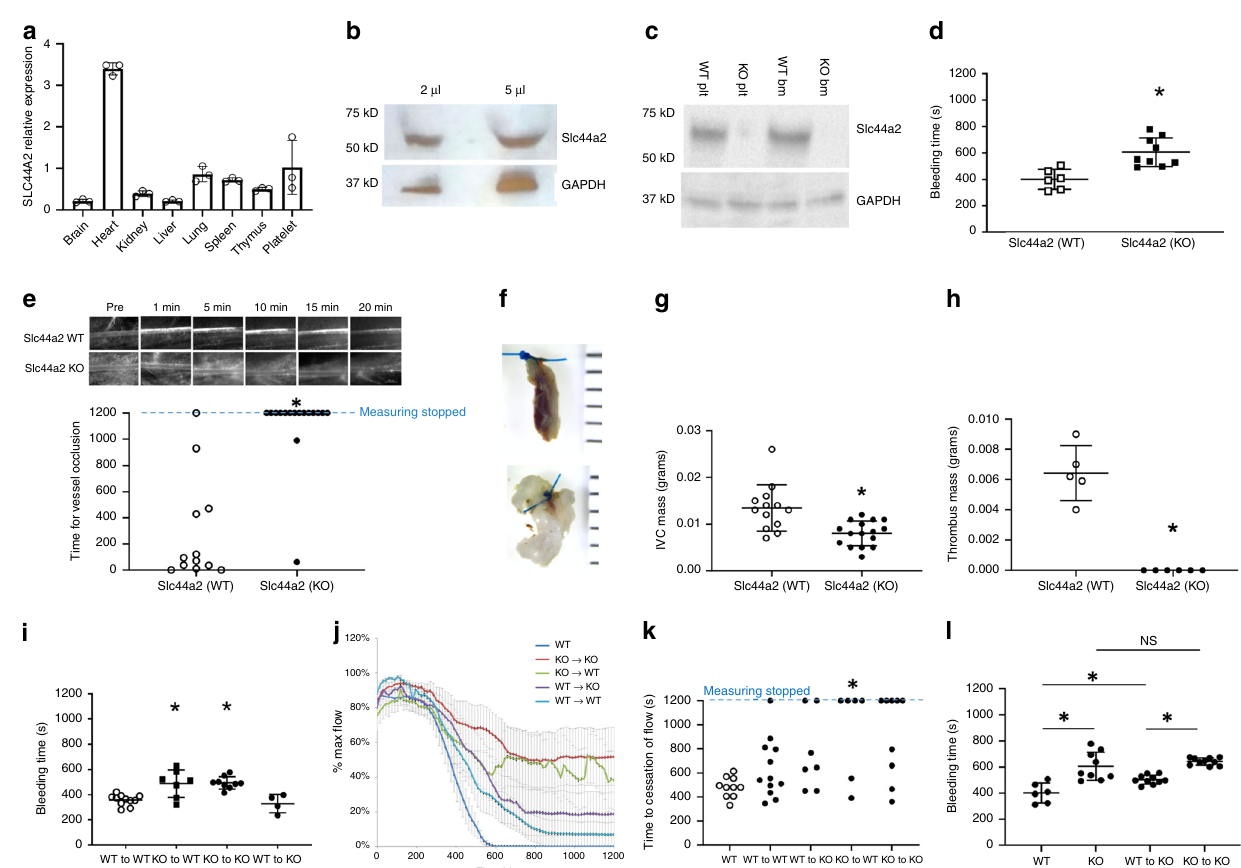
Fig. 1 Slc44a2 is expressed in platelets and regulates hemostasis and thrombosis in mice. a RNA levels of Slc44a2 relative to ß-actin in murine organs were measured by qPCR ( n = 3 ± biologically independent samples ±S.D.). b Protein levels of SLC44A2 in normal human platelets were measured by immunoblotting. c Protein levels of Slc44a2 in mouse platelets and mouse bone marrow were measured by immunoblotting. d The bleeding time of Slc44a2(WT) and Slc44a2(KO) mice was measured after tail transection ( n = 6 WT and 8 KO mice ±S.D. and * P < 0.01 in a two-tailed Student ’ s t test). e The time for mesenteric arterial thrombosis after FeCl 3 treatment was measured by intravital microscopy. *For WT vs. KO, the Fisher ’ s exact test statistic is 0.0001 and the result is signi fi cant at P < 0.05. f Representative image of inferior vena cava 6 h after IVC constriction, with WT above and KO below. g Quanti fi cation of IVC mass containing IVC segment and thrombus 6 h after IVC constriction ( n = 13 WT and 15 KO mice ±S.D. and * P < 0.01 in a two- tailed Student ’ s t test). h Quanti fi cation of thrombus mass isolated from IVC 6 h after IVC constriction ( n = 5 WT and 6 KO mice ±S.D. and * P < 0.01 in a two-tailed Student ’ s t test). i Bleeding times were repeated after bone marrow transplantation between Slc44a2(WT) and Slc44a2(KO) mice ( n = 10, 7, 9, and 4 mice as shown in the chart ±S.D. and * P < 0.01 for WT – WT vs. KO – WT and * P < 0.01 for KO – KO vs. WT – KO in Tukey ’ s range test). Bone marrow from Slc44a2(KO) donor mice prolongs the bleeding time of recipient mice. j Percent maximal blood fl ow in carotid artery after treatment with FeCl 3 was measured by ultrasound. k Quantitation of j . For WT – WT vs. KO – WT, the Fisher ’ s exact test statistic is 0.02 and the result is signi fi cant at P < 0.05. For WT – KO vs. KO – KO, the Fisher ’ s exact test statistic is 0.3 and the result is not signi fi cant at P < 0.05 Sample size includes: 10, 12, 7, 6, and 8 as shown in chart. l The bleeding time of Slc44a2(WT) and Slc44a2(KO ) mice was measured after tail transection (WT and KO). ( n = 6, 9, 9, and 8 mice as shown in the chart ±S.D. and * P < 0.01 for WT vs. KO). The bleeding time of Slc44a2(KO) mice after transfusion with platelets from Slc44a2(WT) or Slc44a2(KO) mice was measured after tail transection (WT to KO and also KO to KO). ( n = 10 mice ±S.D. and * P < 0.01 for WT to KO vs. KO to KO compared in Tukey ’ s range test). Source data are provided as a Source Data fi